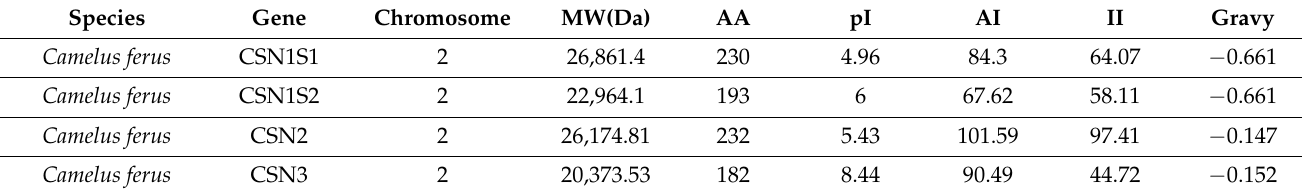
Table 2. Physicochemical parameters of the casein gene family in camelids ( Camelus ferus